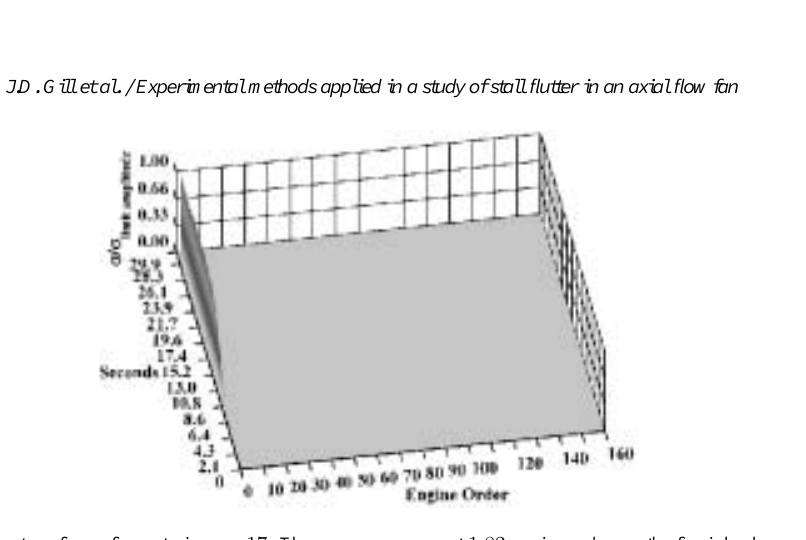
Fig. 9. Successive Fourier transforms from strain gage 17 . The response occurs at 1 . 82 engine orders as the fan is back-pressured into flutter.